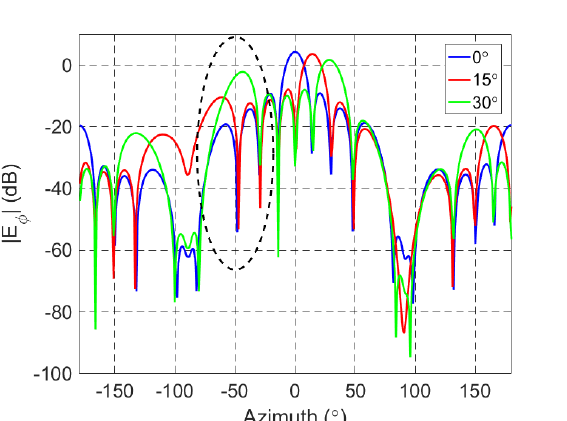
Figure 7. Gain of the Televés 4G NOVA antenna.